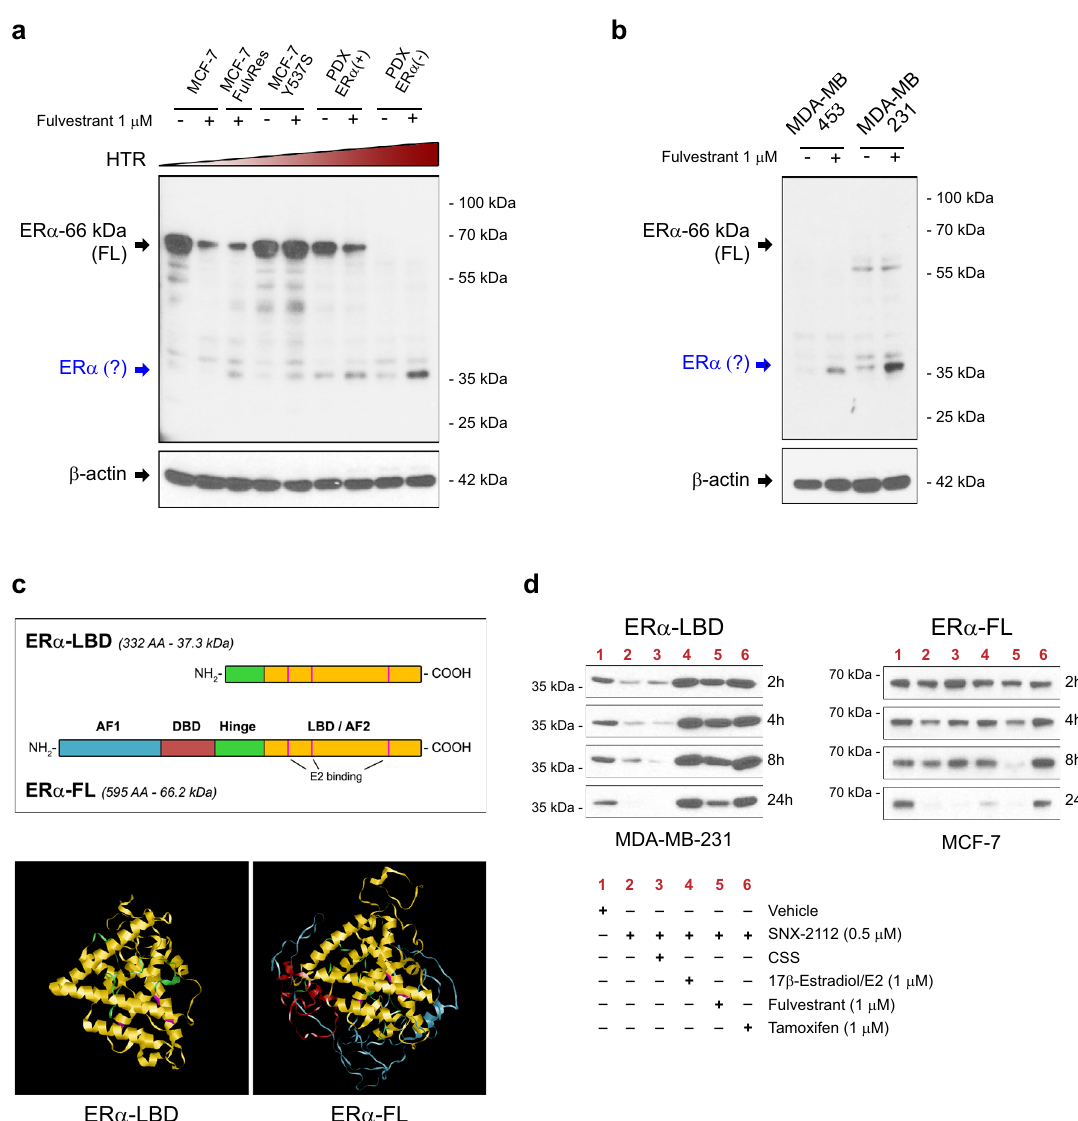
Fig. 1 Fulvestrant resistant BC cell lines express ER α -LBD, a novel estrogen receptor α isoform. a , b Western blot analysis of estrogen receptor alpha (ER α ) protein expression in breast cancer (BC) cell lines. Cells were cultured for 24 h in the presence of vehicle ( − ) or fulvestrant 1 µM ( + ) before lysis. Vehicle = DMSO. ER α protein expression was normalized against β -actin. Increasing levels of hormonal therapy resistance (HTR) are indicated. A potential smaller ER α isoform is indicated in blue. c Comparison between ER α -LBD and ER α -FL (full-length): domains (AF-1, transcription Activation Function-1; DBD, DNA Binding Domain; Hinge; LBD, Ligand Binding Domain; AF-2, transcription Activation Function-2), amino acid (AA) number, molecular weight, 3-D structure prediction (Phyre2). d ER α protein stability assay. ER α -LBD and ER α -FL protein levels were analyzed by western blot in MDA-MB-231 and MCF-7 cells, respectively. Protein samples were collected at different time points (2-24 h), after treatment. Physiological levels of E2 (pM range) were present in all samples, except samples in lane 3 and 4. Vehicle DMSO, CSS charcoal-stripped serum. Source data are provided as a Source Data fi